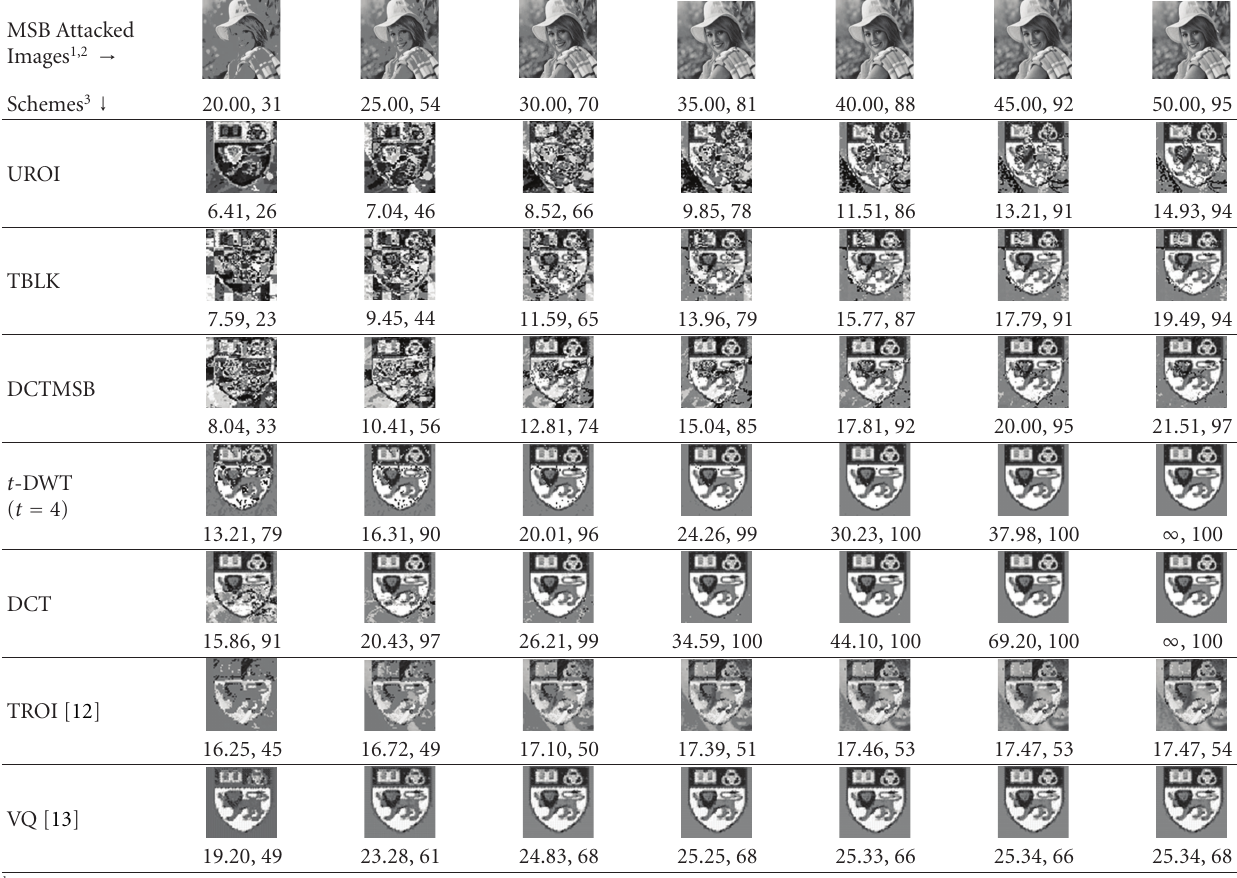
Table 8: MSB attacked images along with their corresponding retrieved logos using Elaine image and NUS logo by di ff erent approaches of the proposed MSB-based scheme and existing TROI-based [12] and VQ-based [13] schemes. MSB Attacked